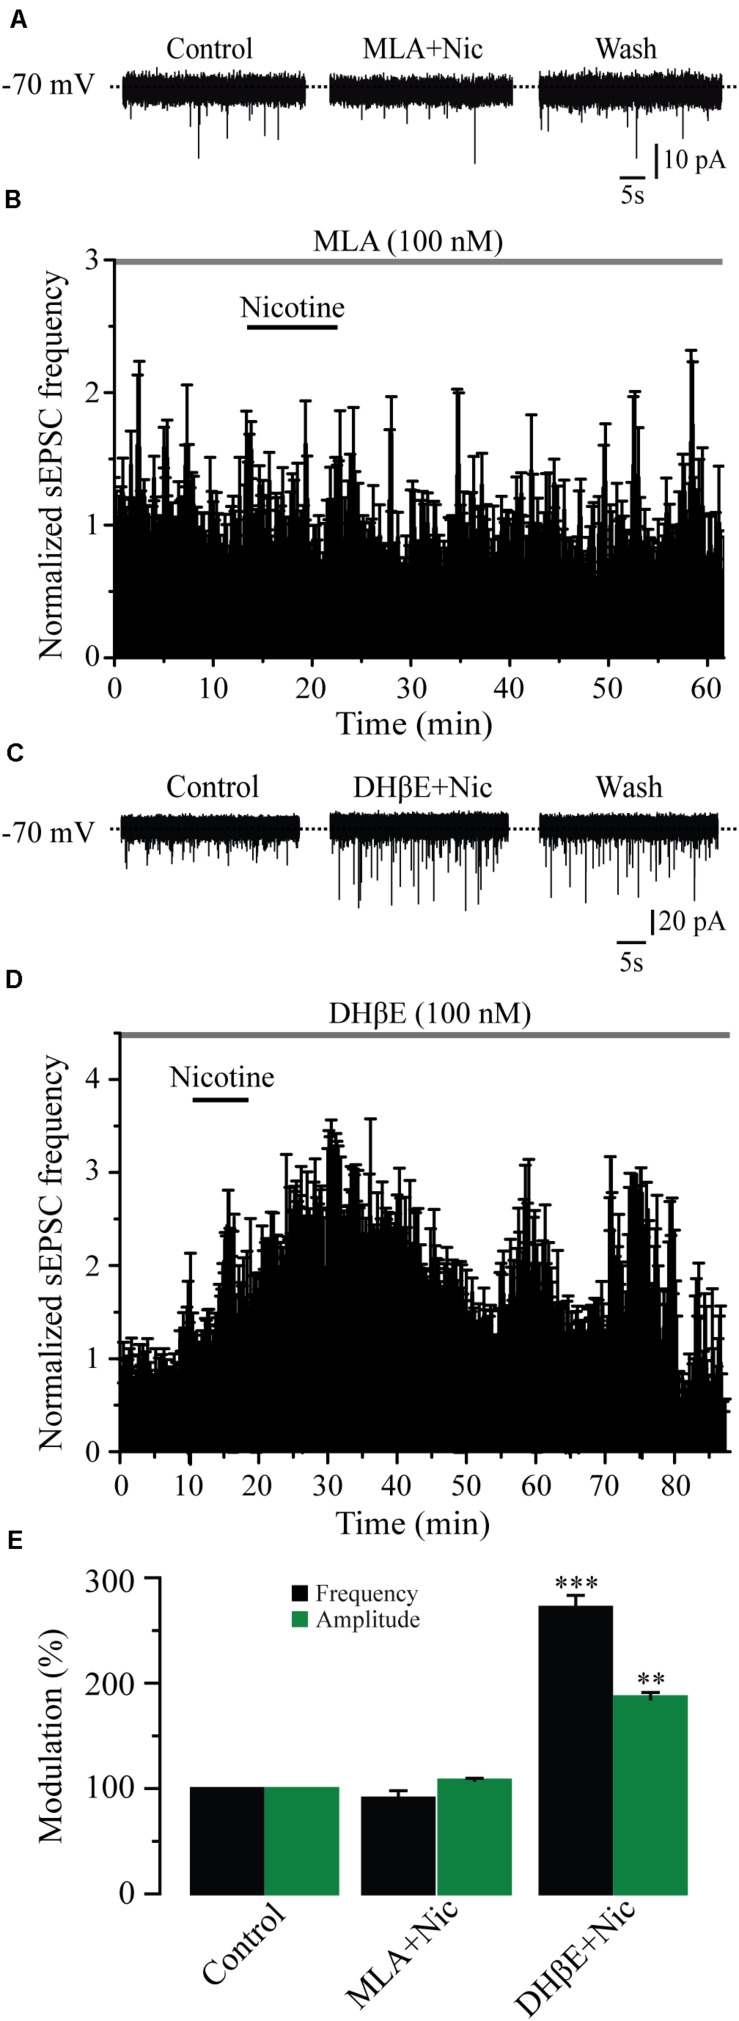
Nicotine effects are mediated through α7 but not α4β2 nAChRs. (A) Current traces showing that MLA (100 nM), a selective antagonist of the α7 nAChRs, completely blocked the effects of nicotine on sEPSCs, control condition (left), 10 min after nicotine plus MLA (middle), and nicotine washout (right). (B) Normalized time-frequency histogram showing the lack of effect of nicotine in the presence of MLA (n = 6). (C) Current traces showing that DHβE (100 nM), a selective antagonist of the α4β2 nAChRs did not block the effect of nicotine on sEPSCs. (D) Normalized time-frequency histogram showing that nicotine increased the frequency of sEPSCs in the presence of DHβE (n = 6). (E) Bar graph illustrating a summary of the data (Mann–Whitney U-test). **p < 0.01, ***p < 0.001.